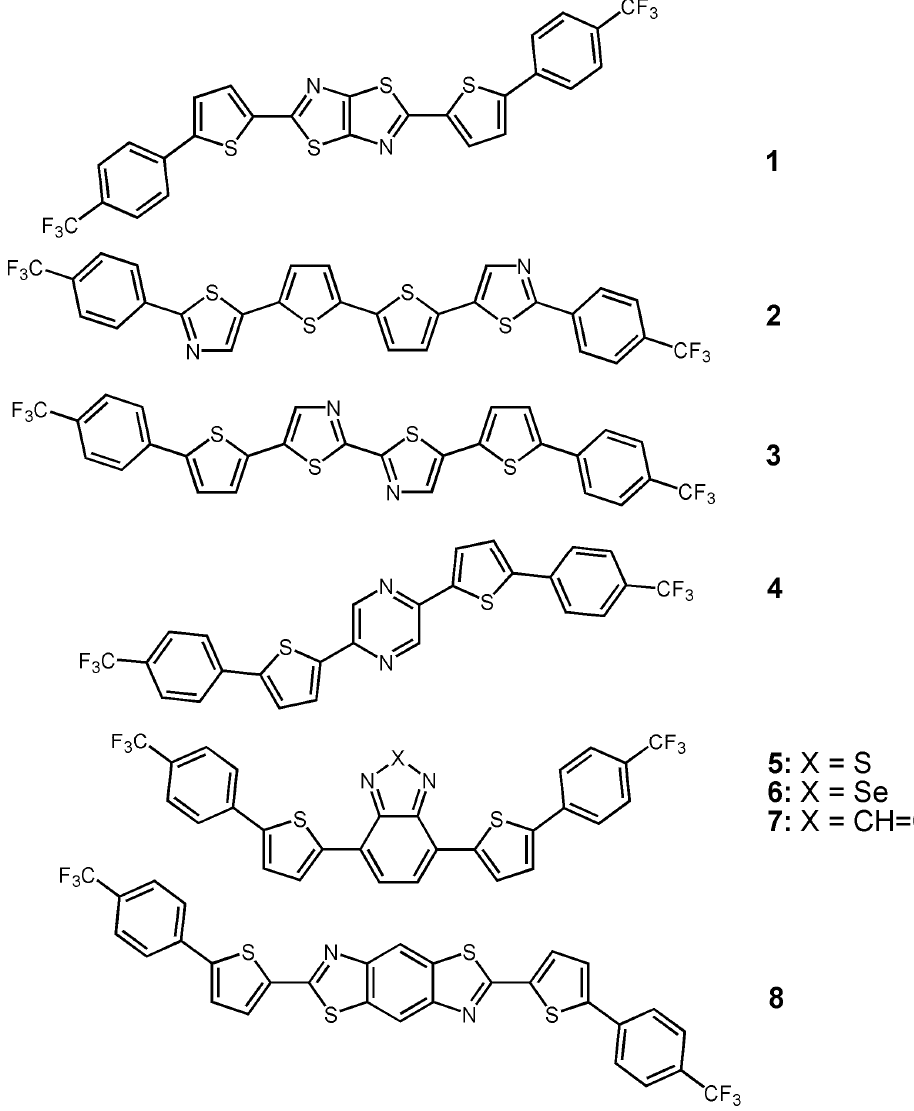
Figure 6. Chemical structures of trifluoromethylphenyl-functionalized n-channel azine- and azole-